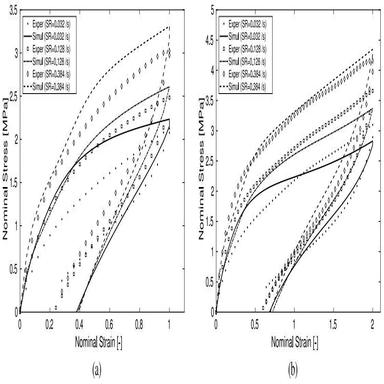
Model validation with strain rates of 0.032 /s, 0.128 /s, and 0.384 /s: (a) 100% strain, (b) 200% strain.